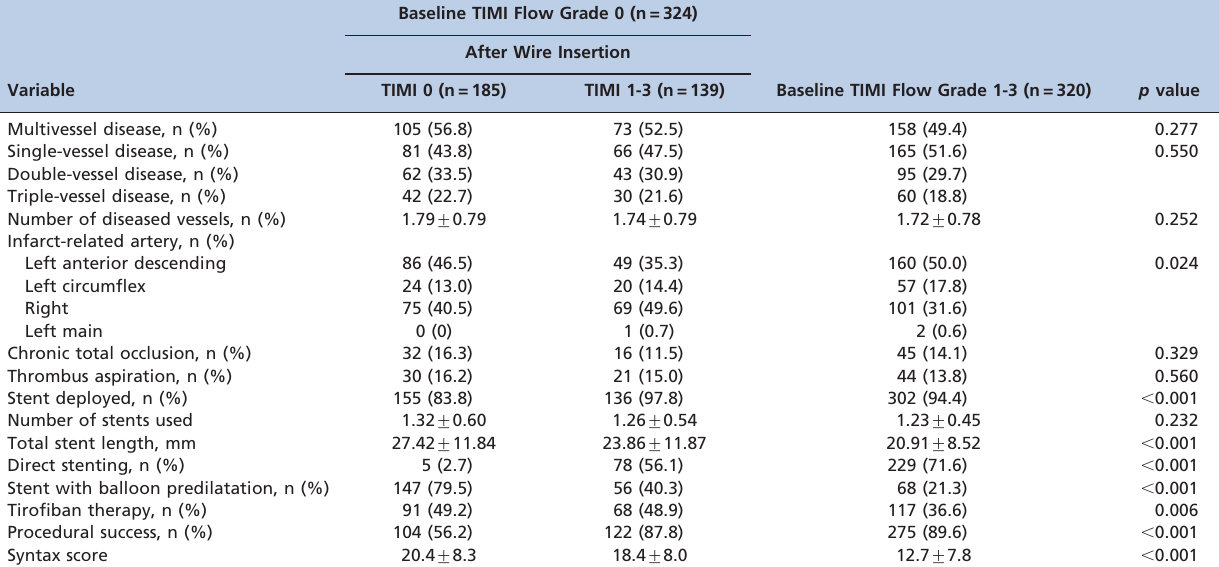
Baseline TIMI Flow Grade 0 (n=324) After Wire Insertion